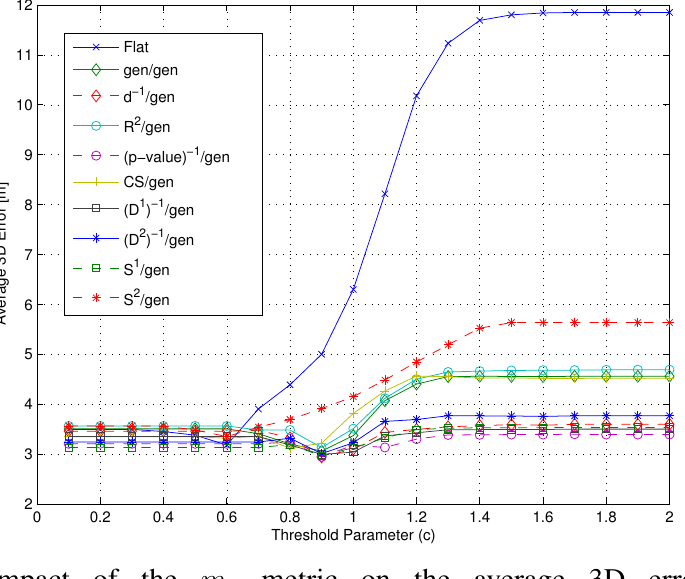
metric on the average 3D error ¯ (cid:15) : flat vs. 1